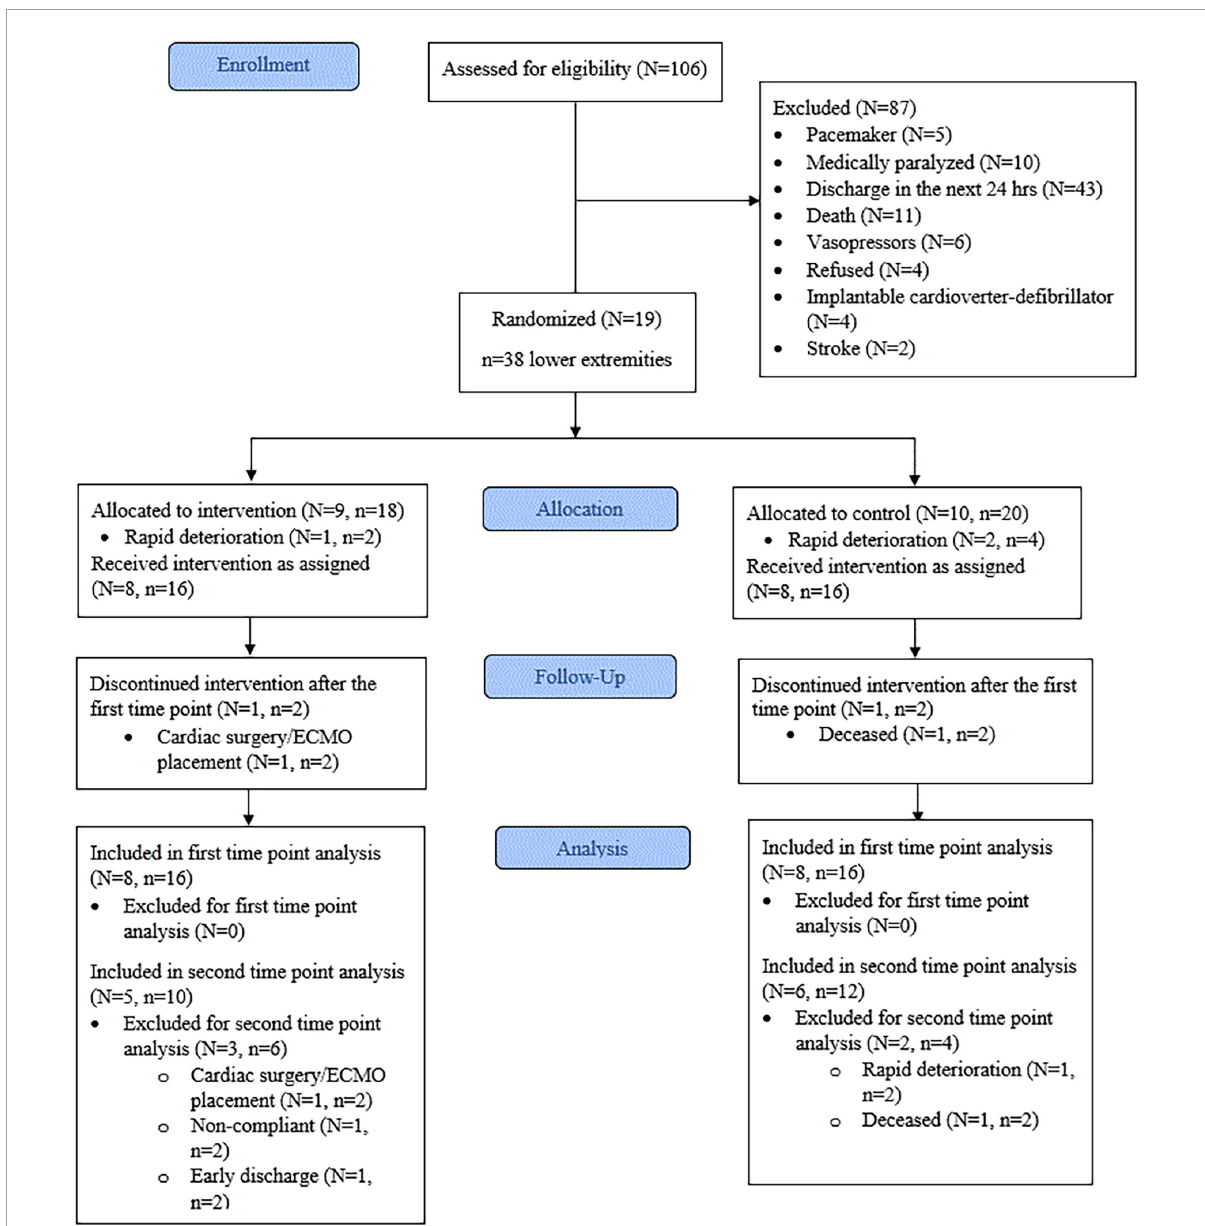
FIGURE3 Consort flow diagram. N, number of patients. n, number of lower extremities. ECMO, extracorporeal membrane oxygenation. First time point = 3 days. Second time point = 9 days.